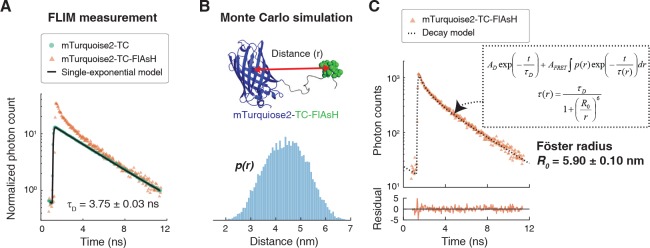
Förster radius estimation by FLIM-FRET measurements and Monte Carlo protein simulations.(A) Fluorescence decay curves of cells expressing mTurquoise2-TC in the absence (green circle) and the presence (orange triangle) of FlAsH. A single-exponential model (black solid line) was fit to the fluorescence decay curve in the absence of FlAsH. For easier comparison, the fluorescence decay curves were normalized such that they asymptotically overlap. (B) The conformational ensemble of the flexible tether between mTurquiose2 and TC were modeled by Monte Carlo protein simulations, and the distance, r, between mTurquiose2 (blue cartoon) and TC-FlAsH (green ball) was estimated. This distribution is denoted by p(r). (C) The measured fluorescence decay of mTurquoise2-TC-FlAsH (orange triangles, same as (A) but not normalized) plotted with the best-fit decay model (black dotted line, model described in the box and derived in Materials and methods). Associated weighted residual (deviation of model from data, divided by the square root of the number of photons) plotted below. Fitting the decay model to the data estimated the Förster radius to be 5.90 ± 0.10 nm (SE).